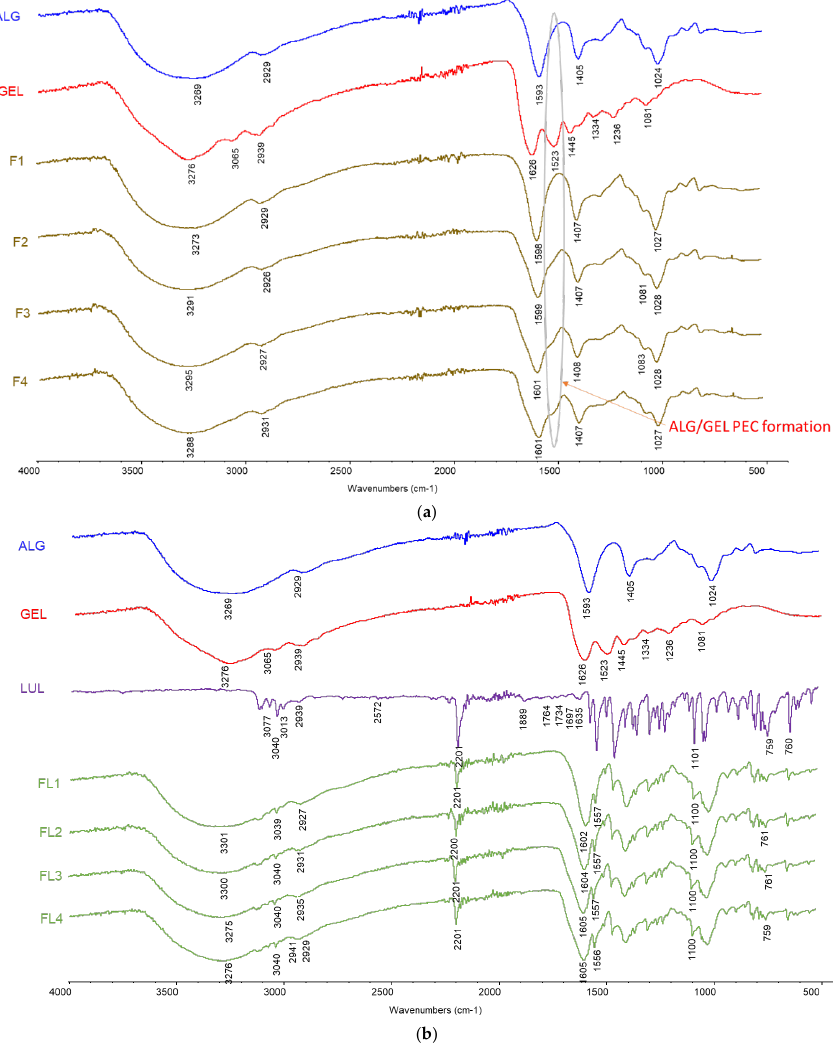
Figure 12. FTIR-AR spectra of ( a ) ALG, GEL, and placebo formulations (F1 – F4) and ( b ) ALG, GEL, LUL, and LUL-loaded formulations (FL1 – FL4).